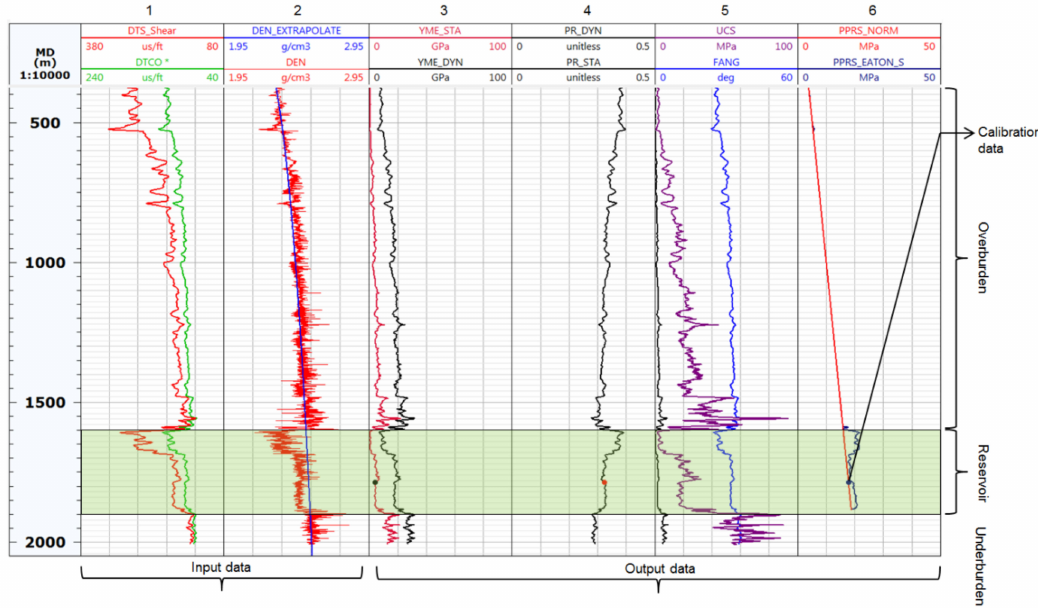
Figure 10. Summary of calculated mechanical properties along with input log data of Well